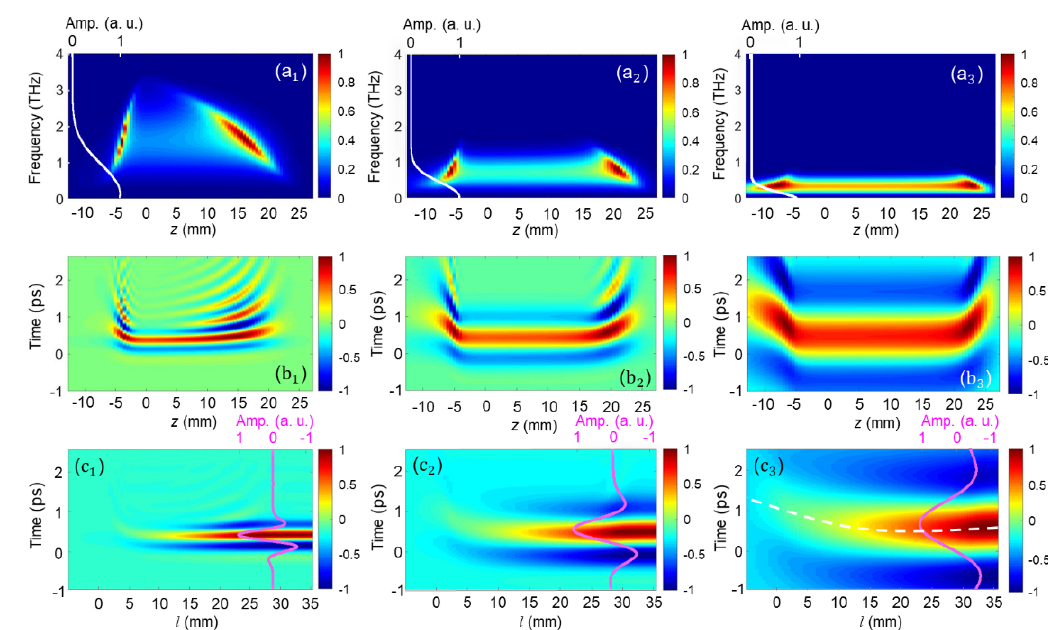
Figure 4: The temporal THz waveforms detected with different bandwidths. (a) The low-pass filtered results of 2-D THz spectrum distributions, achieved by multi- plying the data in Fig. 3(b) by the window functions (white lines) overlapped on the left side of (a -a ), whose upper cutoff frequencies (at 1 / e 2 ) are 1.8, 0.9 and 1 3 0.45 THz, respectively. (b) The corresponding 2-D THz distributions in time domain at each point z . (c) The integrated outcomes of (b) as a function of the filament length l . The purple lines highlight the final THz waveforms from the whole plasma